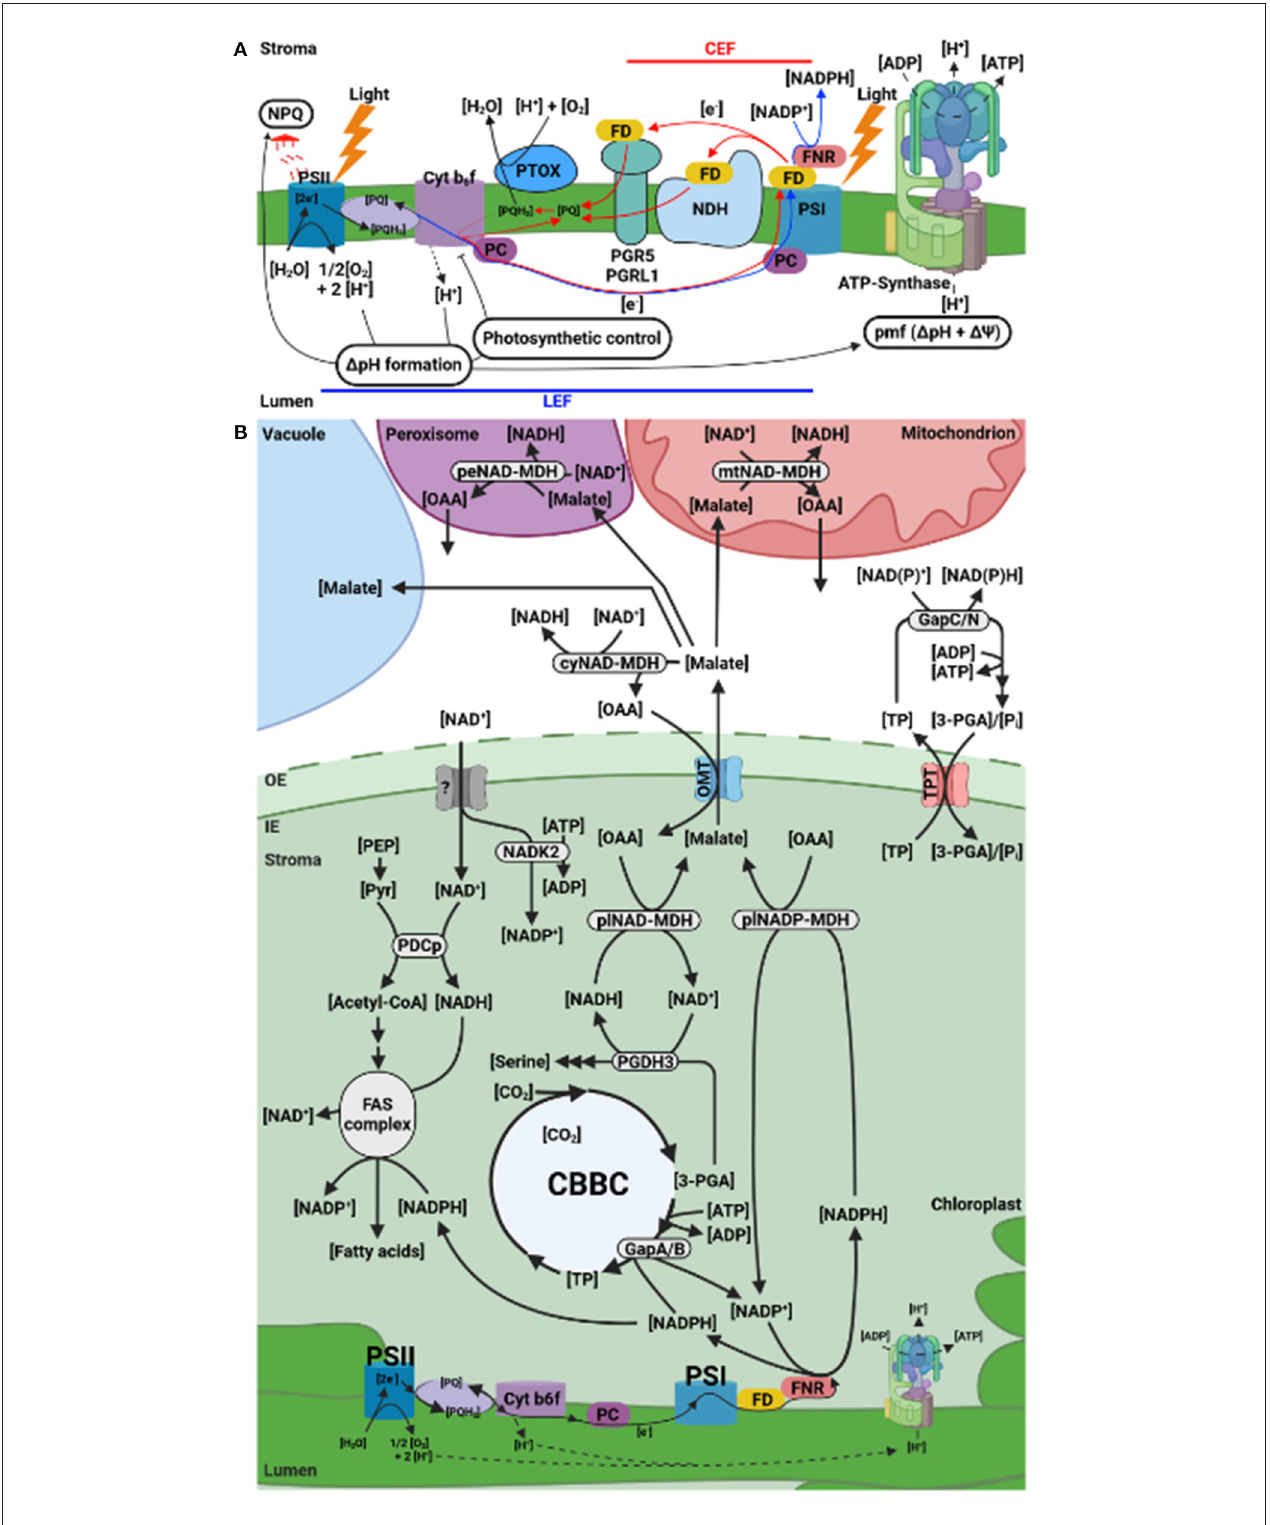
FIGURE 1 | Plastid electron (e − ) flow and indirect export of reducing equivalents. (A) Cyclic (red) and linear (blue) e − flow/ transport (CEF and LEF, respectively) across the thylakoid membrane. Recycling e − from reduced FD back to PQ by CEF allows for ATP production without NADPH formation. The pmf generated by LEF and CEF drives ATP synthesis at the ATP synthase complex. An excess of reduced PQH 2 can be avoided via PTOX activity (modified from Yamamoto and Shikanai, 2020).